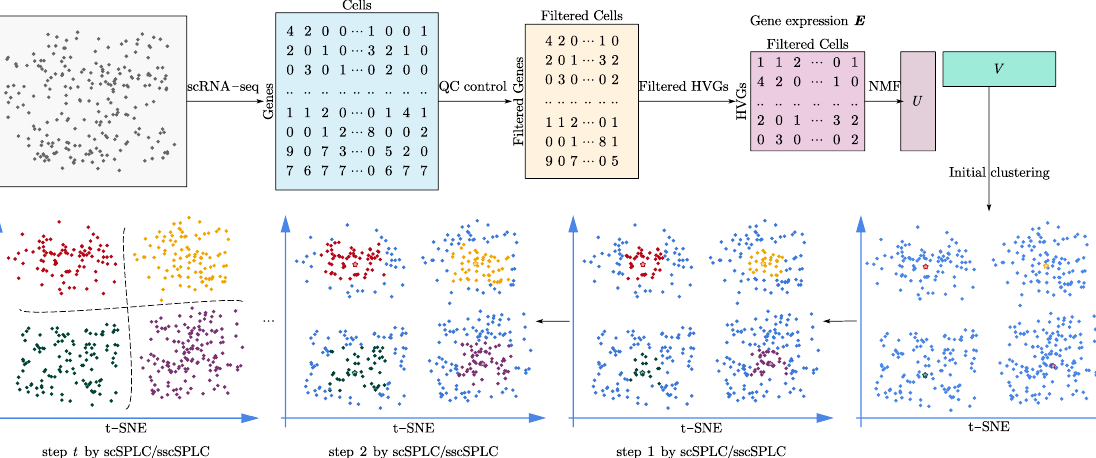
Figure 1. Workflow for single cell self-paced clustering (scSPaC) and sparse single cell self-paced